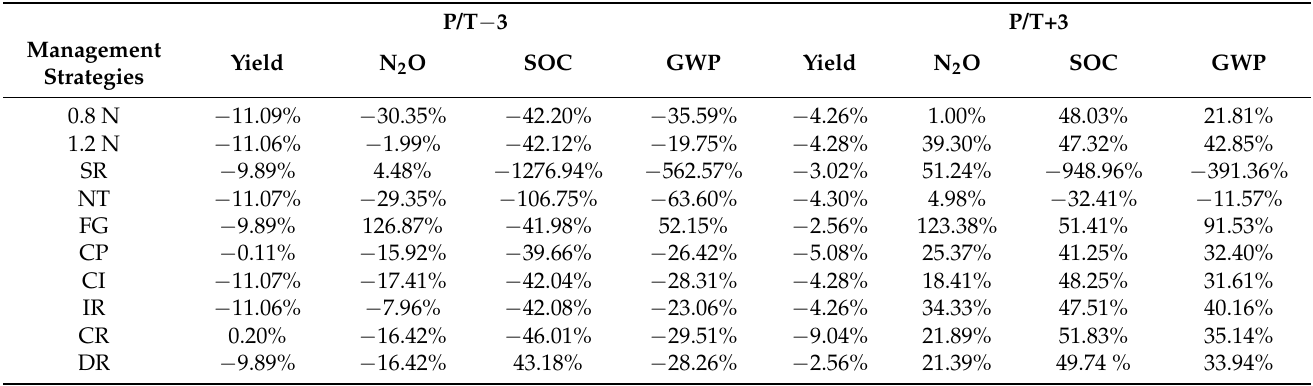
Table 4. The effects on annual yield, N 2 O emissions, and SOC loss under the P/T − 3 and P/T+3 scenarios. P/T − 3